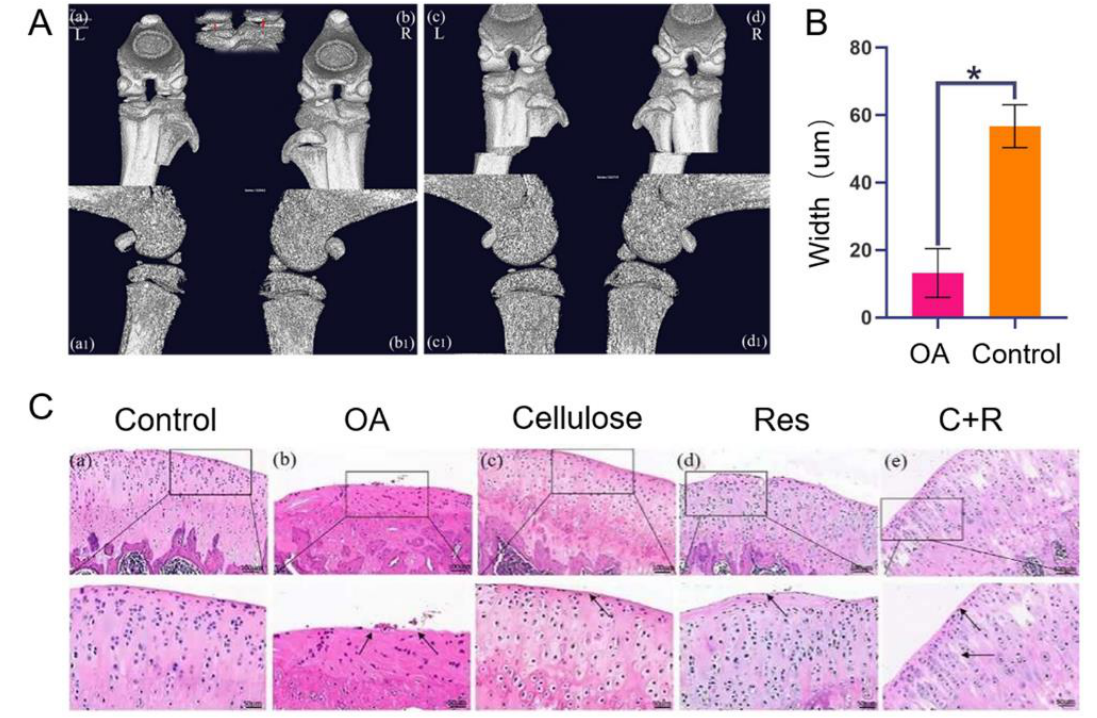
Figure 5. ( A ) Micro-CT examination of knee joint: ( a , b ) Positive bitmap of inflammation group; ( a1 , b1 ) Lateral map of inflammation group; ( c , d ) orthographic map of control group; ( c1 , d1 ) Lateral map of the control group; (B) Knee spacing measurement (* p < 0.05); ( C ) H&E staining images of the weight-bearing area on the medial edge of tibial end of knee cartilage in each group: ( a ) Control: normal Control group; ( b ) OA: arthritis model group; ( c ) Cellulose: the treatment group of Cellu- lose; ( d ) Res: Res treatment group; ( e ) C+R: Cellulose aerogel loaded with Res treatment group (N = 5).